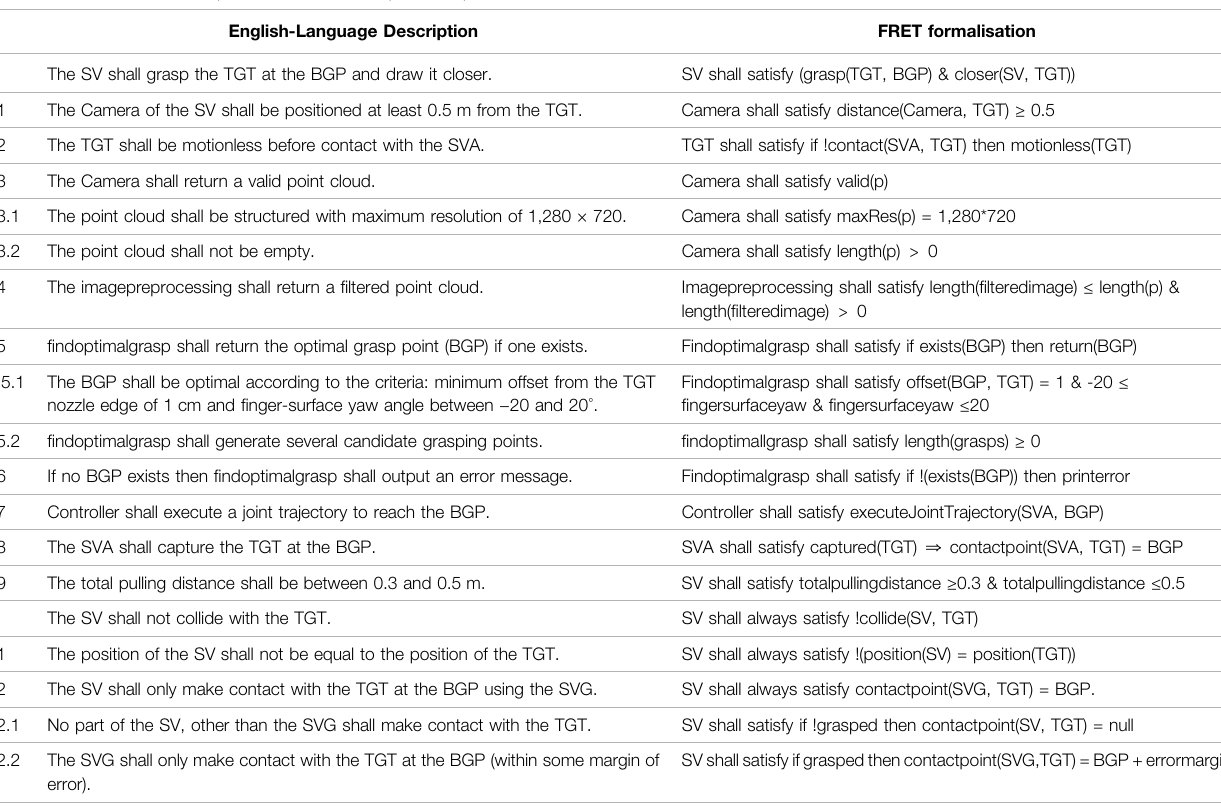
TABLE 1| Natural languagerequirements and their corresponding formalisation inFRET based onthe components illustrated in ourAADL model( Figure 1 ).We encourage the reader to use this table as a point of reference for speci fi c requirements that are mentioned in the text. ID English-Language Description FRET